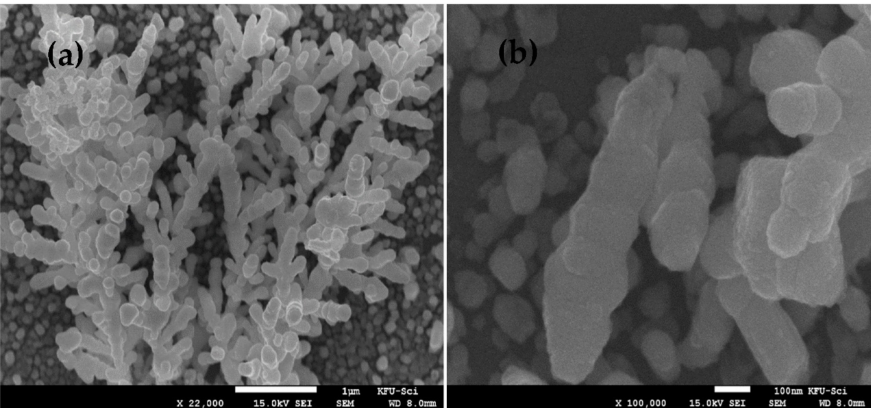
Figure 2. SEM images of silicon nanorods covered with silver and gold nanoparticles. ( a ) With a low magnification × 22,000, 1 µ m scale bar, and ( b ) with a high magnification × 100,000, 100 nm scale bar.